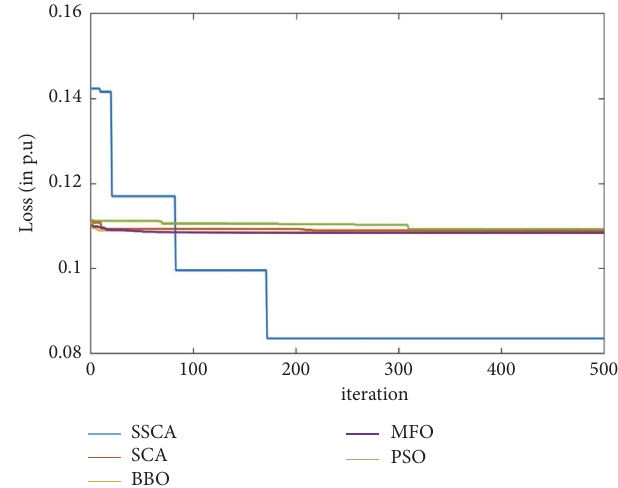
Figure 3: Loss variation in the IEEE-30 bus system at 115% loading.